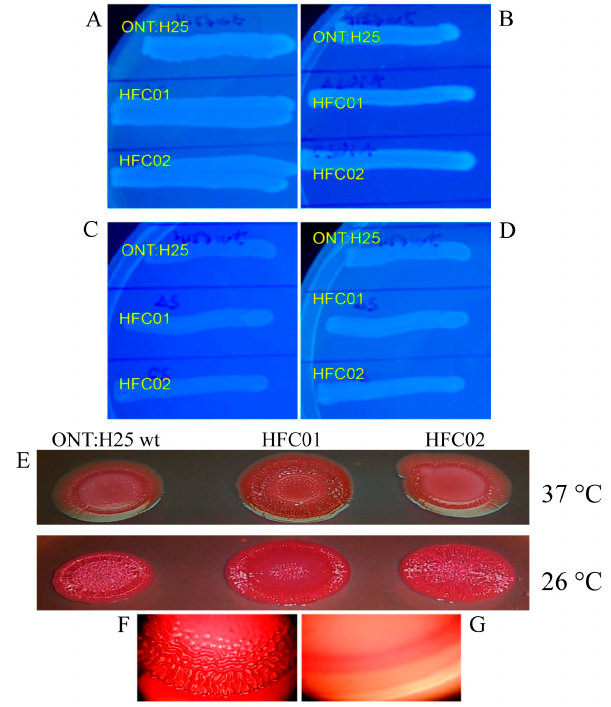
Figure 1. Cellulose production by ONT:H25, sdiA mutant strain (HFC01) and ONT:H25 wild type and complemented strain (HFC02), strains on LBNS agar plates supplemented with calcofluor. ( A , C ) 24 h of incubation at 37 °C and 26 °C, respectively; ( B , D ) 48 h of incubation at 37 °C and 26 °C, respectively. Curli production by ONT:H25, HFC01 and HFC02 strains on LBNS agar plates supplemented with Congo Red and Coomassie brilliant blue, after 24 h at 26 °C. ( E ) ONT:H25, HFC01 and HFC02; ( F ) rdar colonie morphotype. ( G ) smooth colonie morphotype.